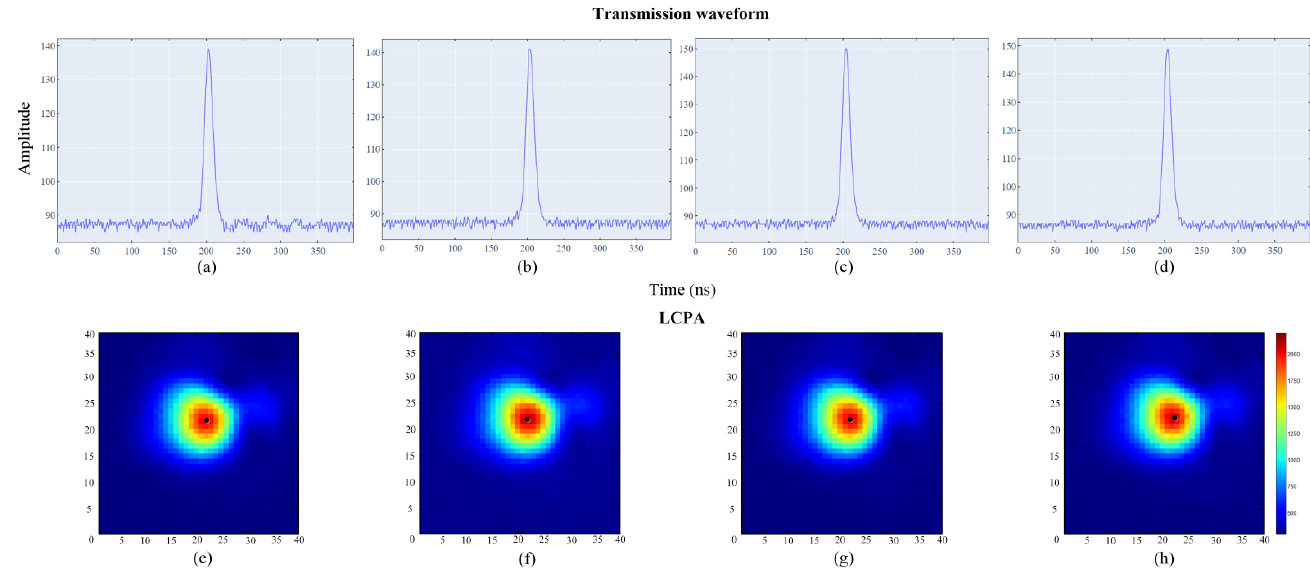
Figure 9. Several typical cases of the optical transfer function (OTF)-laser emission state evaluation (LESE). ( a – d ) Transmission waveform. ( e – h ) LCPA. Table 7. Screening indicators for land area data.